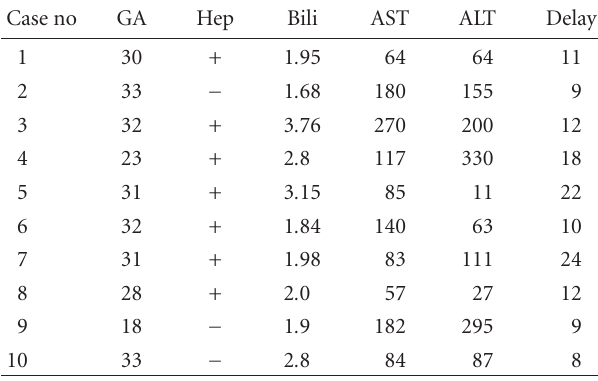
Table 1: Hepatic dysfunction in typhoid fever at pregnancy. GA denotes gestational age (weeks), Hep (+) denotes liver enlargement, Bili denotes bilirrubin (mg/dL), AST denotes aspartate aminotrans- ferase (IU), ALT denotes alanine aminotransferase (IU), and delay denotes days between the beginning of symptoms and therapy